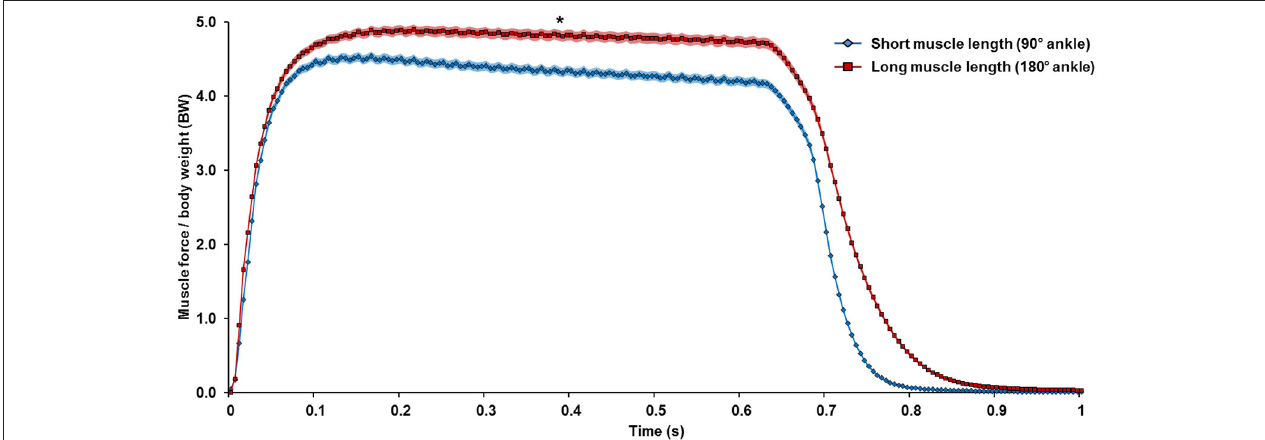
FIGURE 8 | Mean muscle force normalized to body weight (BW) pooled from the trials conducted at the short (118 trials, blue diamond) and long muscle lengths (169 trials, red square) from all nine animals. The color shading indicates the standard error of the mean. On average, the TA muscle generated more force at the long (180 ◦ ankle flexion) than the short length (90 ◦ ankle flexion). * Indicates significant differences in force compared with forces measured at the short muscle length ( p <